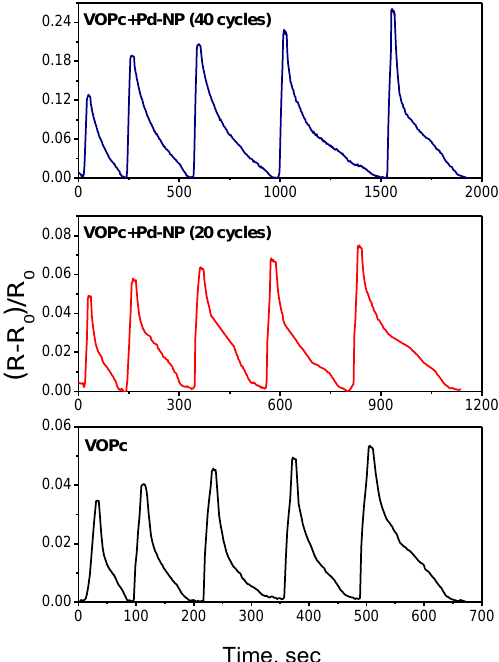
Figure 8. Sensor response of a VOPc film and a VOPc film covered with Pd nanoparticles during 20 and 40 cycles of pulse-chemical vapor deposition (CVD) to hydrogen (100–500 ppm), measured at 80 °C.